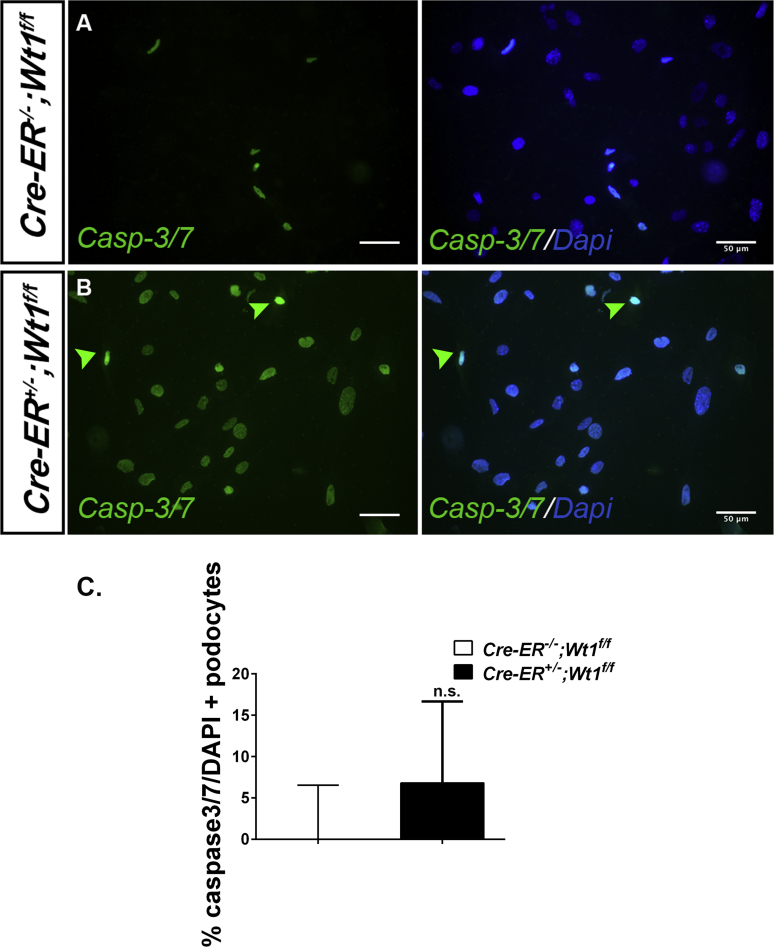
Cleaved Caspase 3/7 is induced in primary CAGG-CreERTM+/−;Wt1f/f transgenic podocytes. (A,B) Representative micrographs following immunofluorescent labeling with anticleaved Caspase-3 & 7 (Alexa 488–conjugated secondary antibody, green arrows) of primary podocytes isolated at D6 P.I. from control (A) and mutant (B) mice. (C) Quantitative graph showing the proportion of median number of cleaved Caspase-3/7–positive podocytes in mutants and controls. Bars represent the median of each group. Error bars represent the interquartile ranges. Median percentage of DAPI-positive, cleaved Caspase 3/7–positive podocytes in controls (n = 9) versus mutants (n = 15): 0% (IQR: 0, 6.56) versus 6.8% (IQR: 0, 16.7), P = 0.19 (not significant), Mann-Whitney U test.